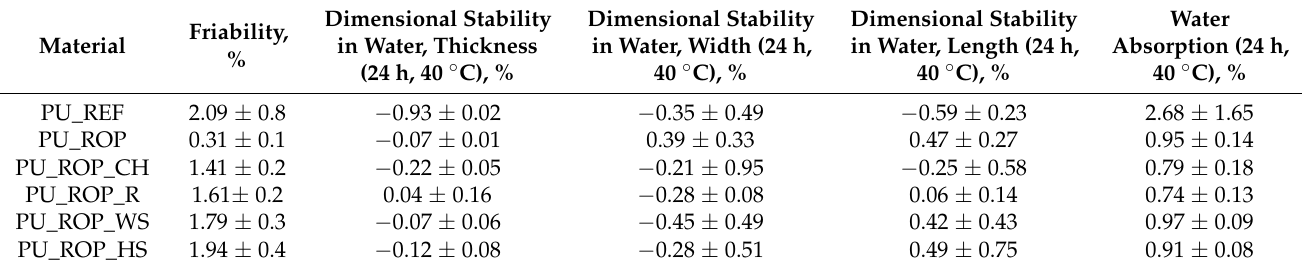
Table 6. Friability, dimensional stability and water absorption of the examined materials.